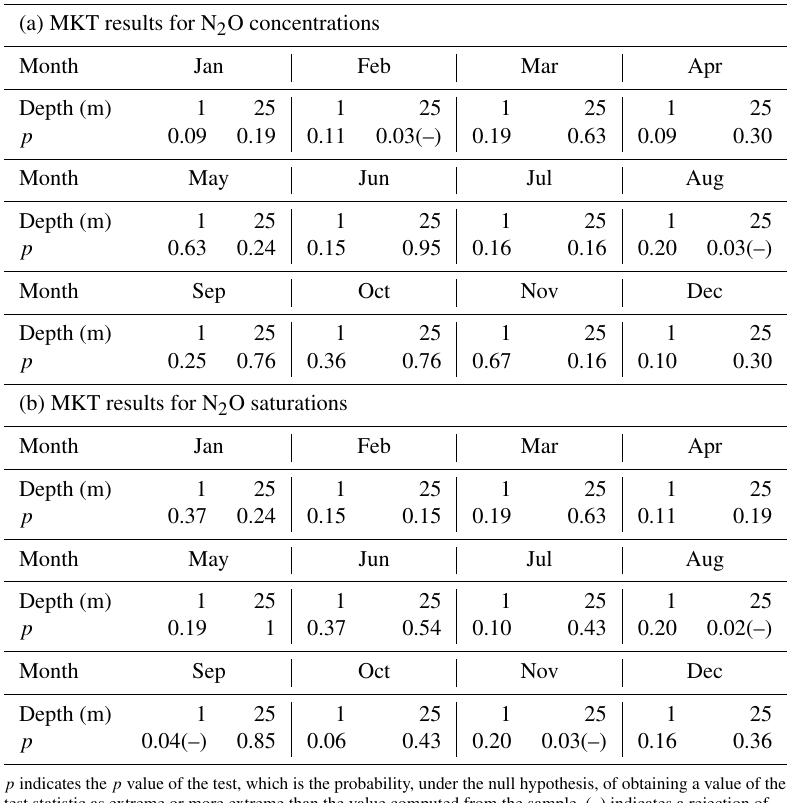
Table 1. The results of the Mann–Kendall test for the surface and bottom N 2 O concentrations and saturations of the 12 individual months. (a) MKT results for N 2 O